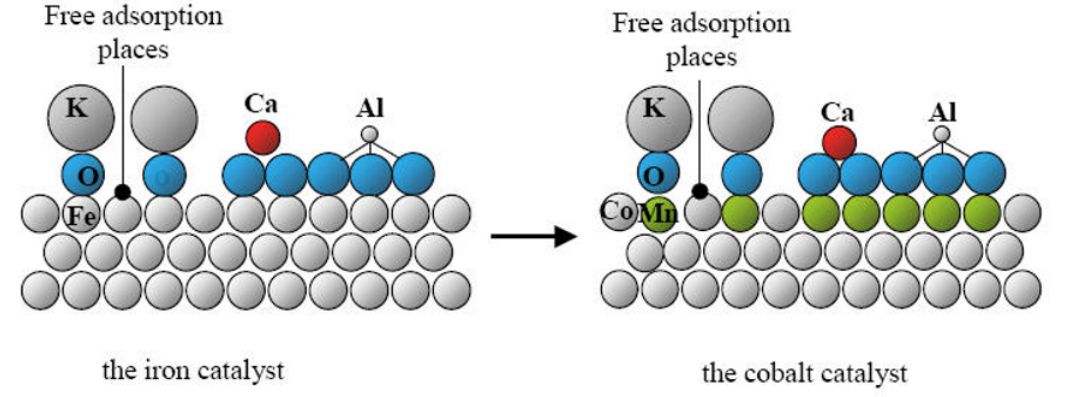
Scheme 1. The models of the iron and cobalt catalyst